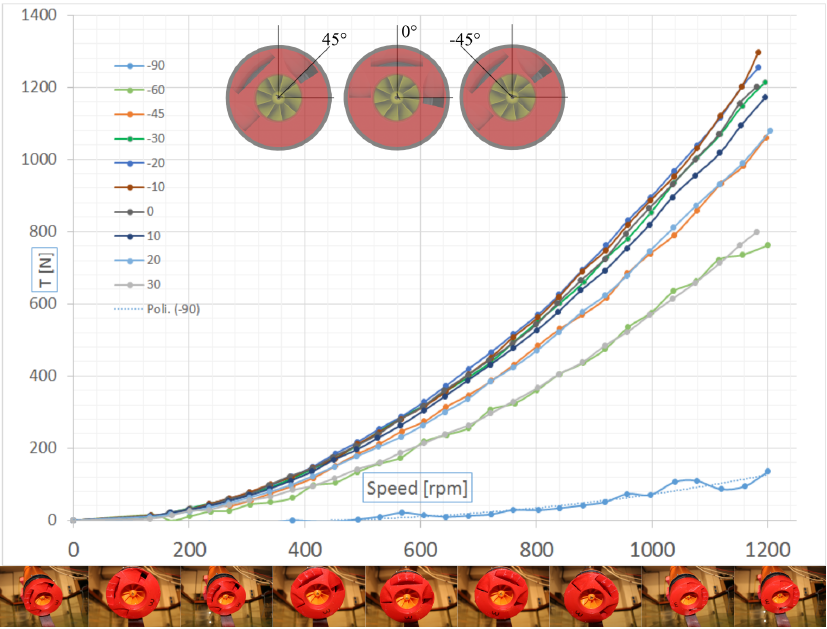
Figure 23. Results of bollard pull thrust tests: thrust vs. RPM at different angles.